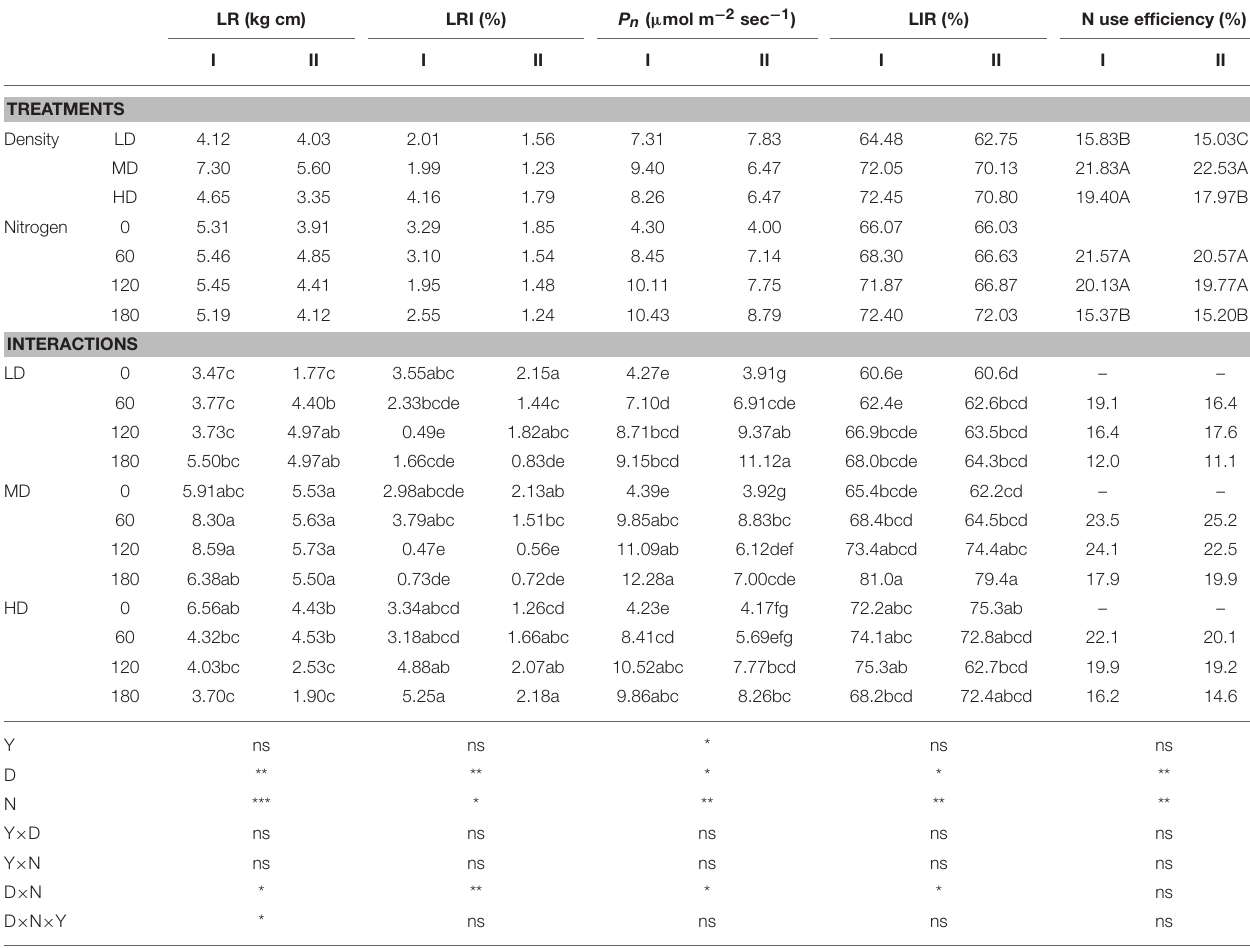
TABLE 4 | Effect of plant densities and N rates on lodging resistance, lodging resistance index (LRI), photosynthetic rate ( P n ), light interception ratio (LIR), and apparent recovery nitrogen use efficiency in the growing season of 2014/15 (I) and 2015/16